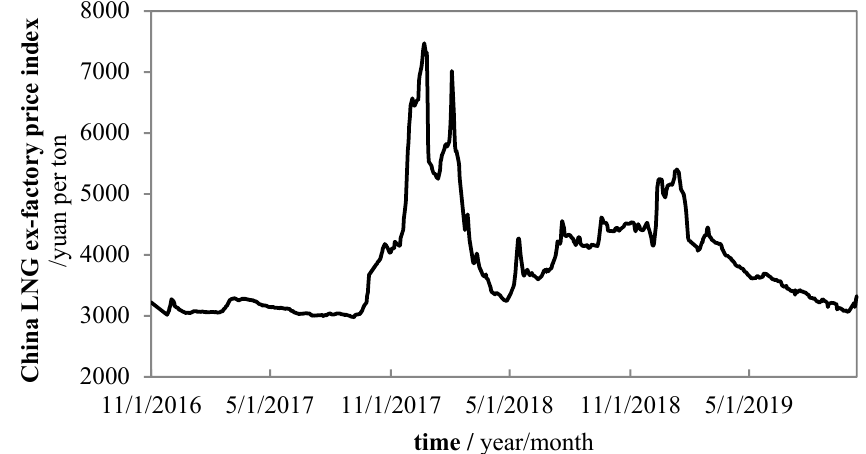
Figure 3. China liquefied natural gas ex-factory price index given by the Shanghai Petroleum and Natural Gas Exchange